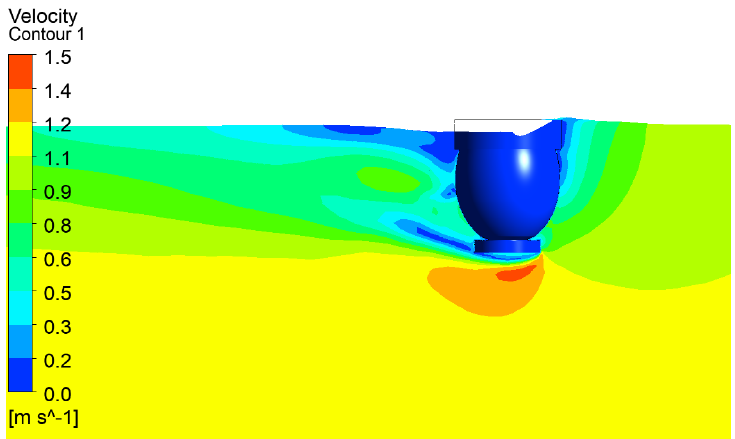
Figure 11. CFD results on the symmetry plane for Re = 7.8 × 10 5 : water